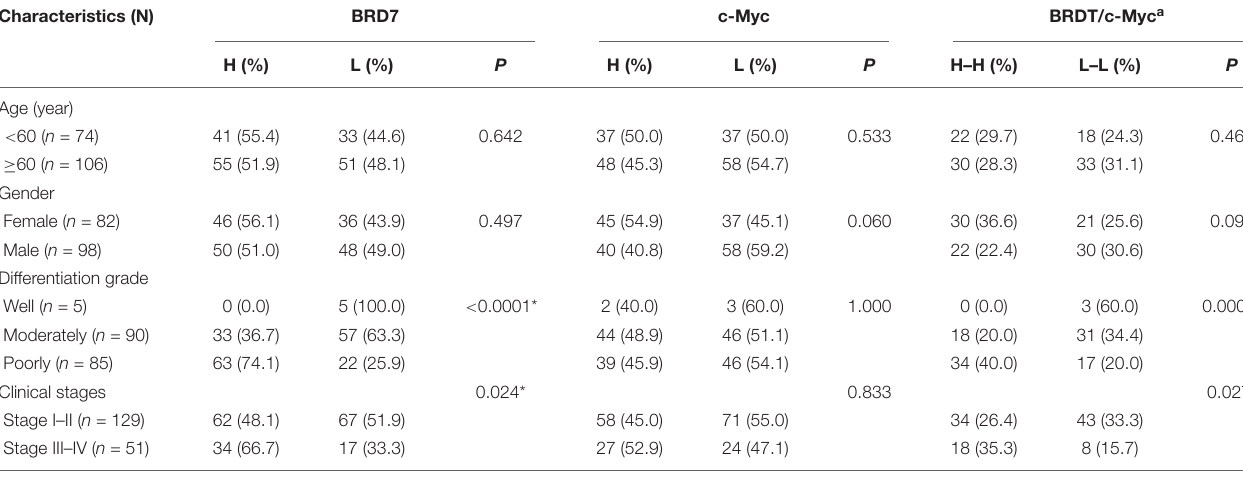
TABLE 1 | Association between the expression of BRD7, c-Myc, and CRC clinical pathological features ( N = 180). Characteristics (N) BRD7